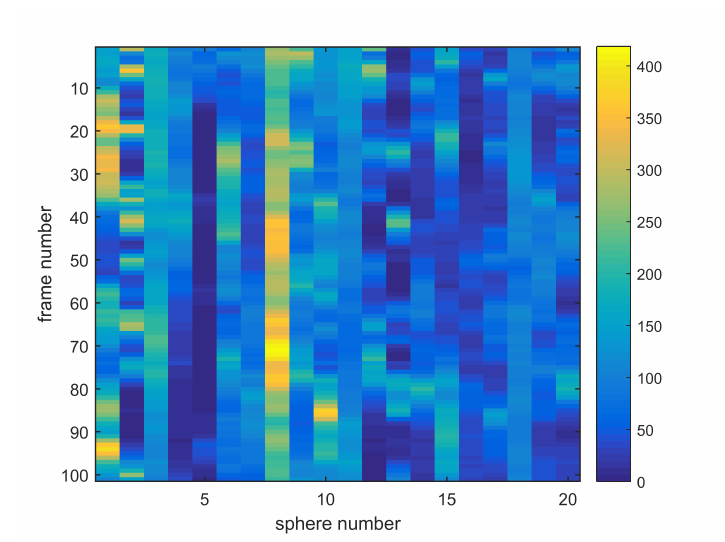
Figure 3. Mode map for an array of twenty spheres with a mean diameter of 74.44µm (the frame number relates to